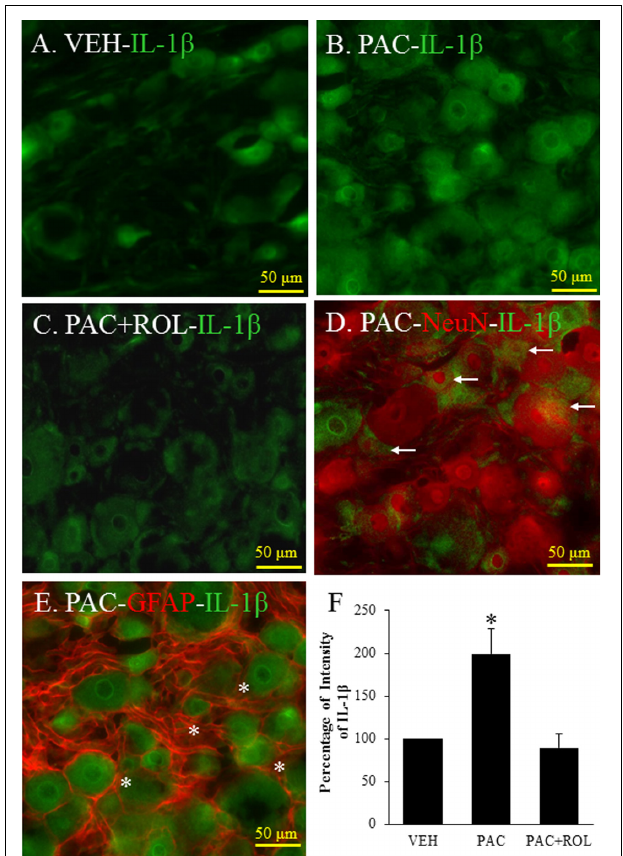
FIGURE 3 | (Representative immunofluorescent images of PDE4) Co-localization of PDE4, NeuN, and DAPI in the L5 DRGs. (A) PDE4 (green, Alexa Fluor 488) in the L5 DRG of a vehicle (VEH; 4% dimethyl sulfoxide and 4% Tween 80 in saline)-injected rat. (B) PDE4 (green, Alexa Fluor 488) in the L5 DRG of a paclitaxel (PAC; 2 mg/kg/1 ml of vehicle)-injected rat. (C) PDE4 (green, Alexa Fluor 488) in the L5 DRG of a paclitaxel + rolipram (ROL; 3 mg/kg)-injected rat. (D) NeuN (red, Alexa Fluor 568) in the L5 DRG of a paclitaxel-injected rat. (E) DAPI (blue) in the L5 DRG of a paclitaxel-injected rat. (F) PDE4 (green, Alexa Fluor 488), NeuN (red, Alexa Fluor 568), and DAPI (blue) in the L5 DRG of a paclitaxel-injected rat. The L5 DRGs of the VEH ( N = 3) and PAC groups ( N = 3) were obtained on day 20 after the first paclitaxel injection. For the ROL group, L5 DRGs were obtained 1 h after intraperitoneal injection of rolipram (3 mg/kg) on day 20. PDE4 was expressed in both neurons and satellite cells in the DRG. Stars and arrows indicates satellite cells and neurons, respectively. Scale bars, 50 µ m.